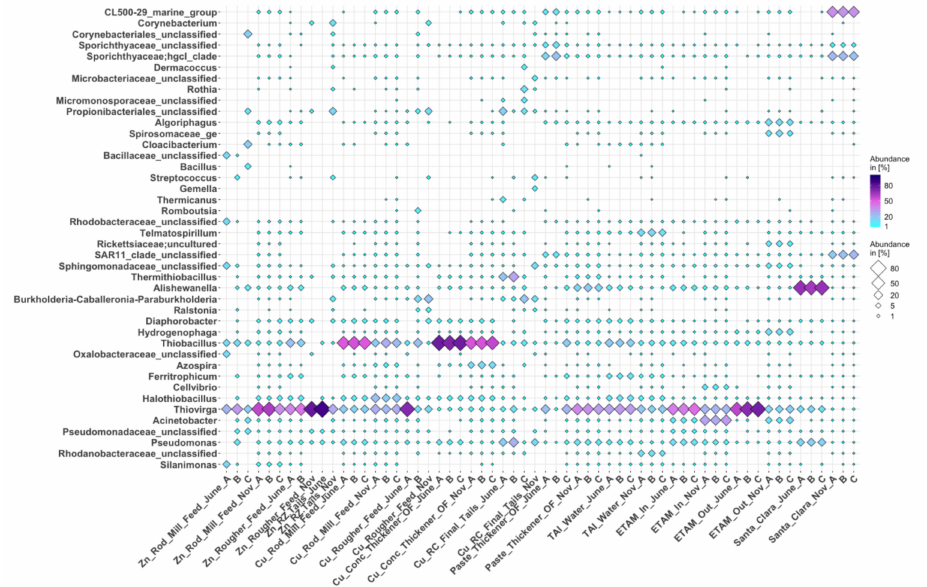
Figure 7. Bacterial genera containing at a minimun 5% relative abundance in at least one sample. Sampling was performed in June and November 2018 originally with triplicate samples but only samples with over 90 reads are shown. The June Cu Rougher Feed sample represents water phase (A) and a mixture of water and solids in the sample (B). The bacterial genera are presented on the left of the graph and the relative abundances of the different genera in each sample are represented by a gradient shading and size of the diamonds.